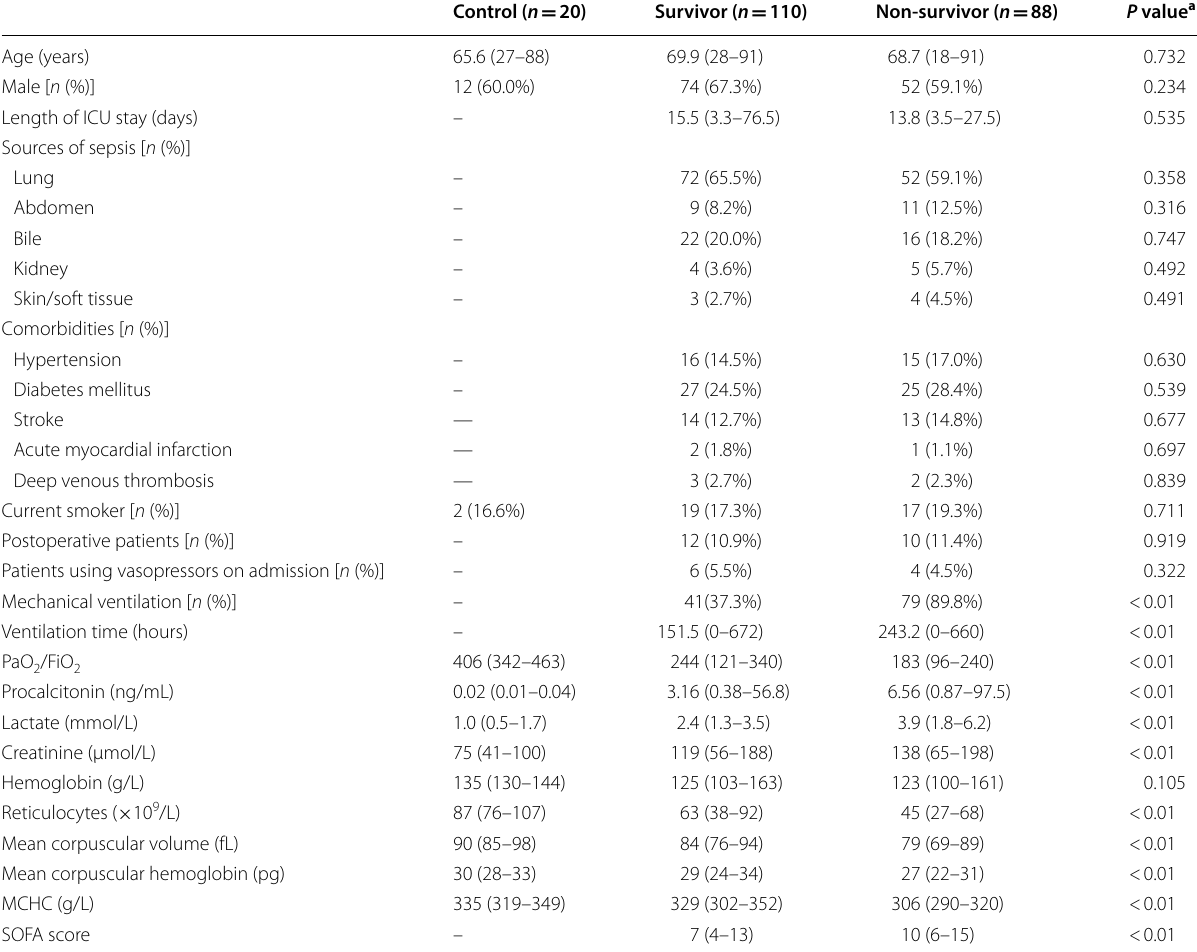
Values are the median (range) ICU intensive care unit; NS not significant; SOFA Sequential Organ Failure Assessment; MCHC mean corpuscular hemoglobin concentration a Indicates the P values for the comparison of survivor and non-survivor